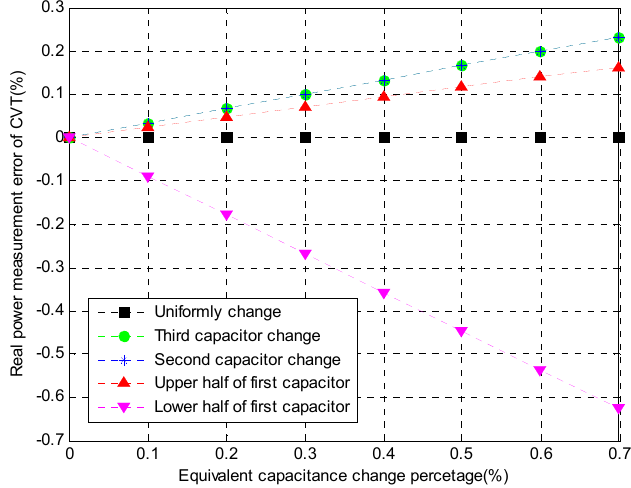
Figure 14. CVT real power measurement error with different equivalent capacitance.